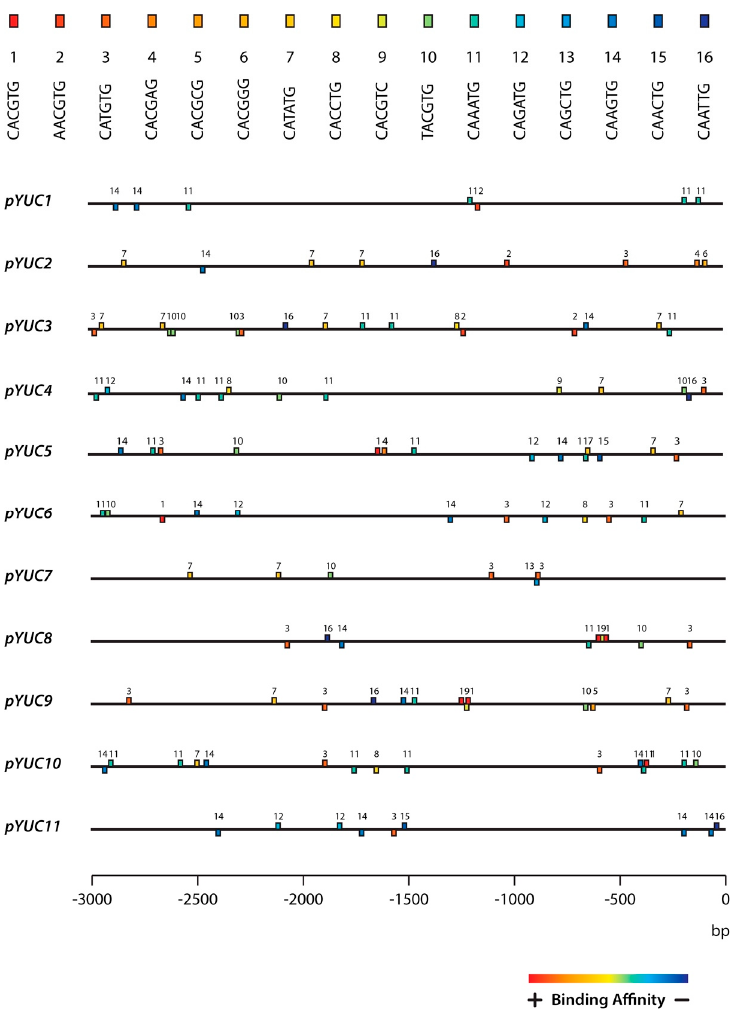
Figure 3. The promoters of YUC8 and YUC9 present a specific G-boxes binding motif configuration. Schematic representation of the distribution of G-box and putative G-box variants in the promoter of Arabidopsis YUCCA genes. The -3000 to -1 promoter region upstream to the transcriptional start codon (ATG) of the eleven YUC family members is shown. All reported G-boxes are color-coded (square) and associated with a specific sequence. Numbers indicate the corresponding G-box nucleotide sequence, with number 1 being the described canonical G-box. Colors indicate different experimental MYC2 binding affinities [32] . Next, we studied whether the observed cis -regulatory elements are indeed involved in the transcriptional regulation of YUC8 and YUC9 . To this end, we performed a transient